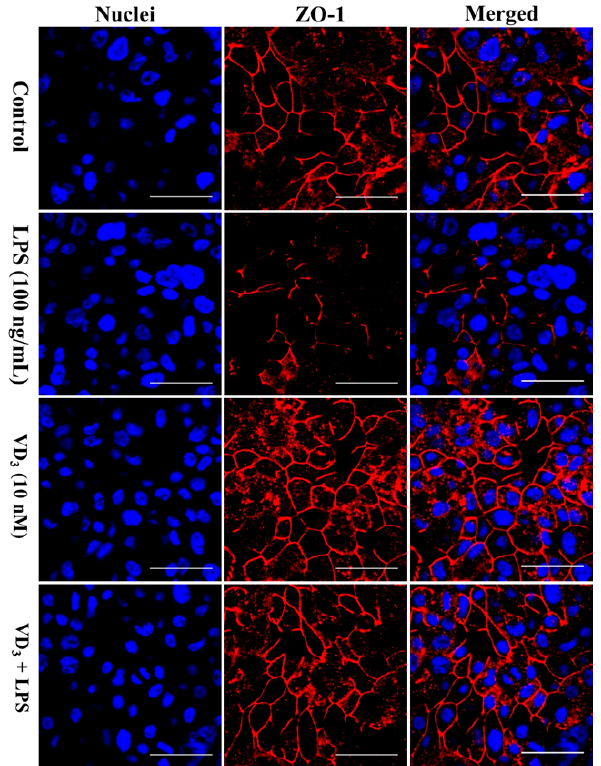
Figure 3. Immunofluorescence analysis of the tight junction molecule, ZO-1, in NCI-H441 cells. The NCI-H441 cells were treated with the conditioned media from the mono-culture of VD 3 (10 nM) and LPS (100 ng/mL)-treated OECs to restore the co-culture condition in the Transwell ® system. The cell nuclei were counterstained with Hoechst (blue) and ZO-1 in NCI-H441 cells was stained with anti-ZO-1 antibody (rabbit) and Alexa 555 (donkey, anti-rabbit) (red), magnification: 63 folds, scale bar: 50 µm.